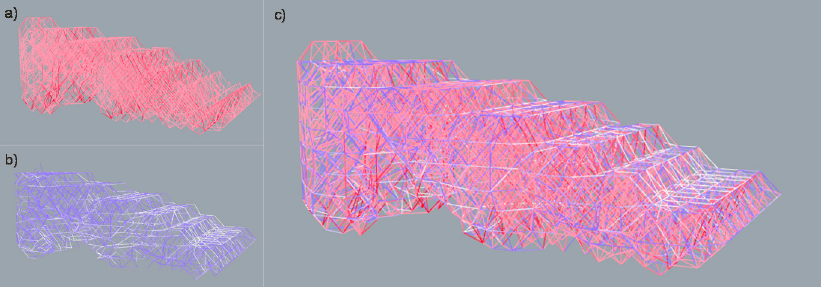
Figure 32. Visualization of the results of the FEA. ( a ) Bars subjected to compression; ( b ) Bars subjected to tension; ( c ) the whole of the structure with colour differentiation between the bars subjected to tension and compression.